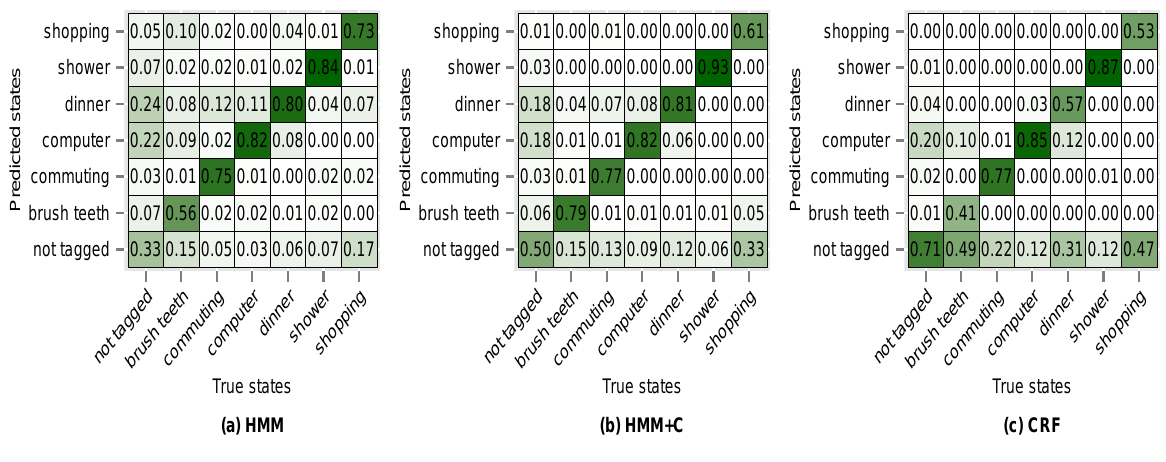
Figure 12. Confusion matrices for experiment 4 (subject 1): PBM subclassing.